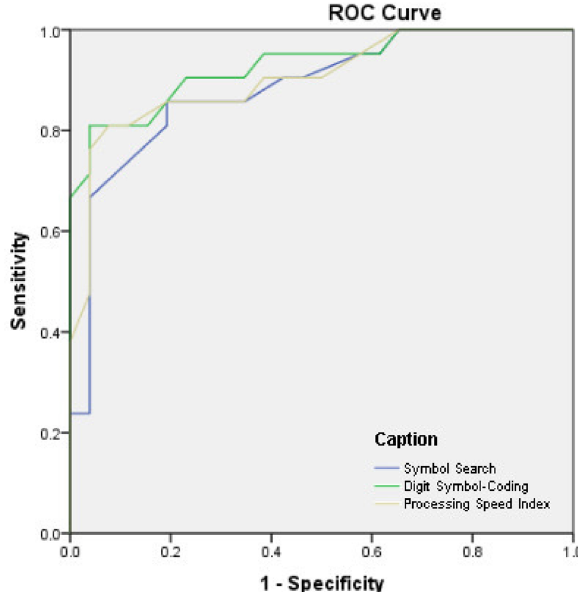
Figure 2. Analyses of Receiver Operating Characteristic curve, sensitivity, and specificity for Alzheimer’s disease versus control